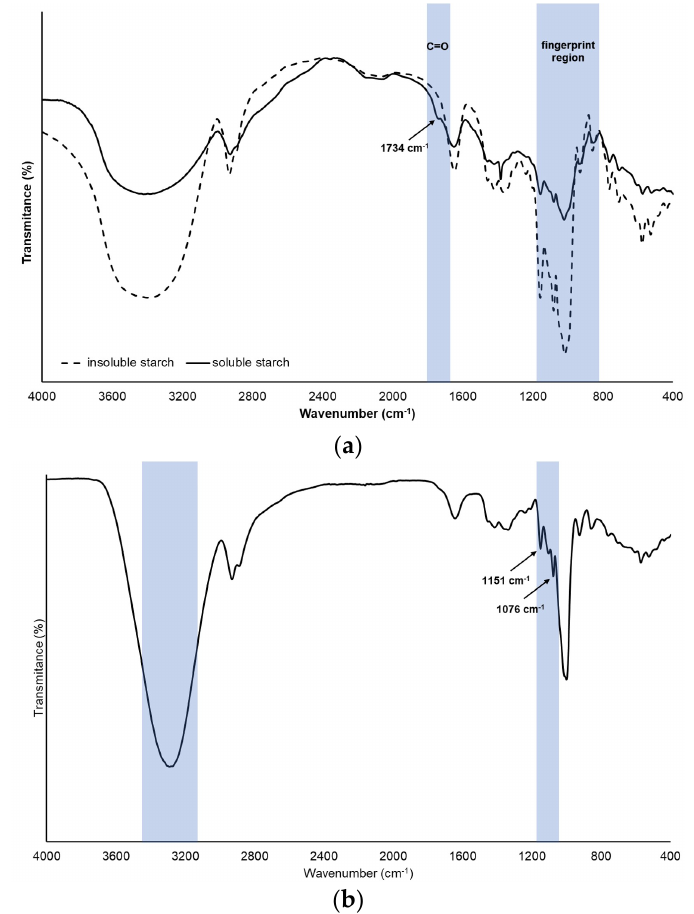
Figure 4. FTIR spectra from ( a ) soluble and insoluble starches isolated from S.lycocarpum ; and ( b ) starch − PEJP films.